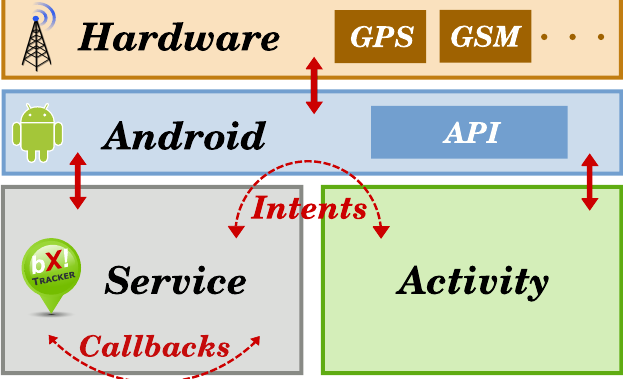
Figure 4. Architecture of the BX Tracker